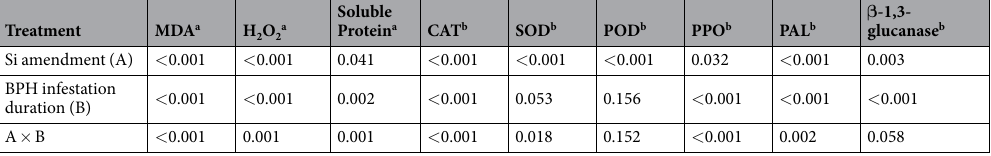
Table 2. Two-way analysis of variance for significance ( P value) of the effects of Si amendment and Nilaparvata lugens infestation duration on rice physiological parameters. a Concentrations measured, b Activities measured. Si amendment at 0 or 112 mg Si/kg nutrient solution, N. lugens (BPH) infestation duration: 0, 24, 48, 72 or 96